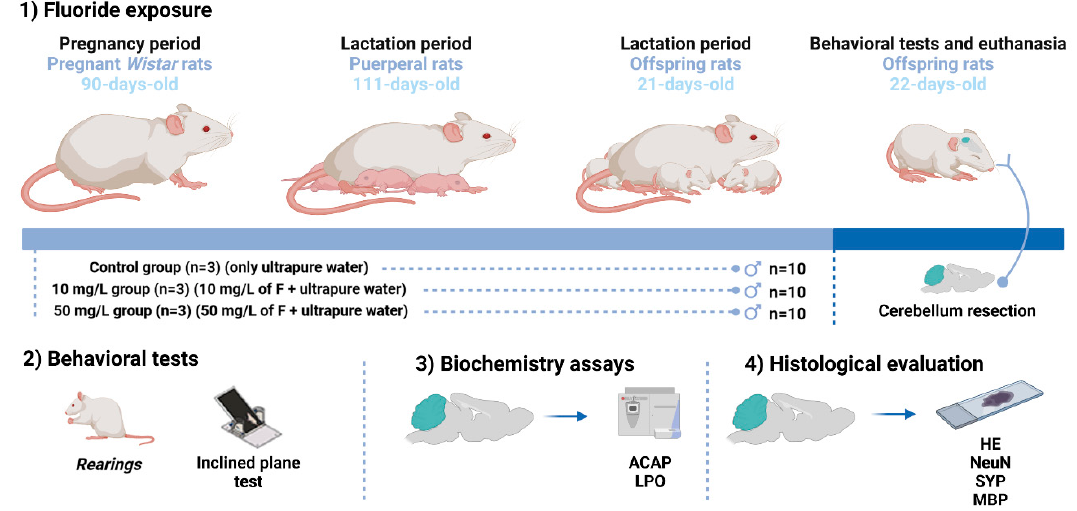
Figure 4. Methodological steps of the study. Experimental groups, fluoride exposure and cerebellum resection ( 1 ). Behavioral tests: Number of rearing and Inclined plane test ( 2 ). Histological evaluation: Hematoxylin & Eosin (HE) staining, Anti-NeuN immunostaining, Anti-Synaptophysin (SYP) immunostaining and Anti-Myelin basic protein (MBP) immunostaining ( 3 ). Biochemistry assays: Antioxidant capacity against peroxyl radicals (ACAP) and Lipid peroxidation (LPO) ( 4 ).